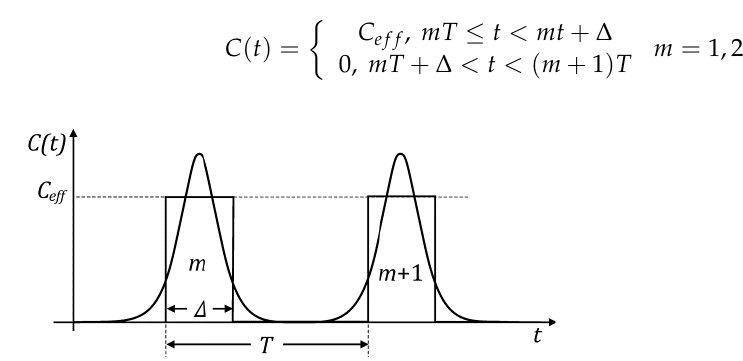
Figure 7. The approximation of a bell-shaped spike by a piece-wise constant function. The corresponding duty ratio